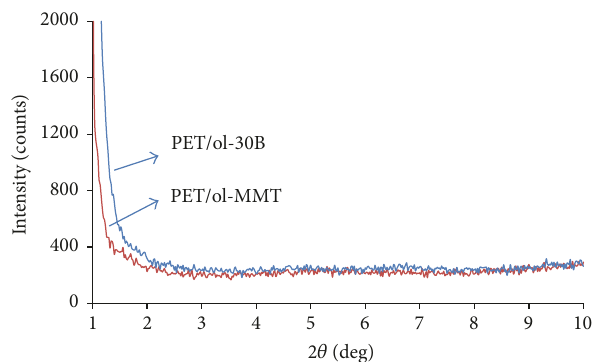
Figure 7: XRD results of 2 wt.% PET/ol-MMT and PET/ol-30B nanocomposites.